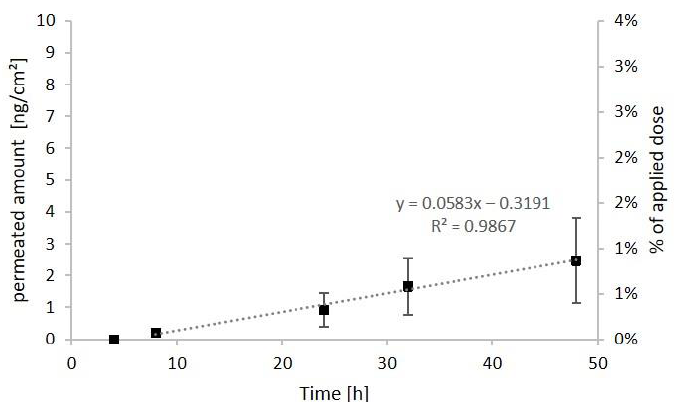
Figure 4. Cumulative permeated amount of H-DMCA relative to skin area (left axis) and percent of total applied dose (right axis) in the receptor fluid over time (4–48 h), n = 6. The dashed regression line is based on the absolute permeated amounts (left axis). It represents the linear range used to calculate the steady-state flux, which is the slope of the regression line.